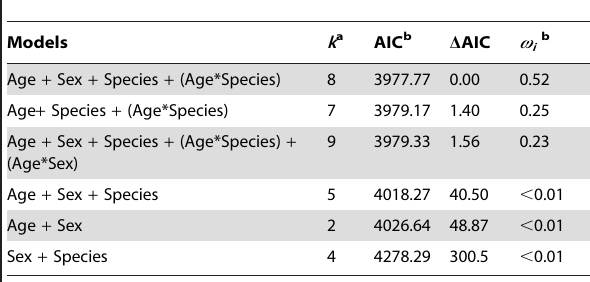
Table 2. Logistic regression models of variation in avian influenza virus (AIV) seroprevalence in waterfowl sampled in Alaska, USA, 1998–2010 ( n =3405), examining the effects of age while controlling for sex and